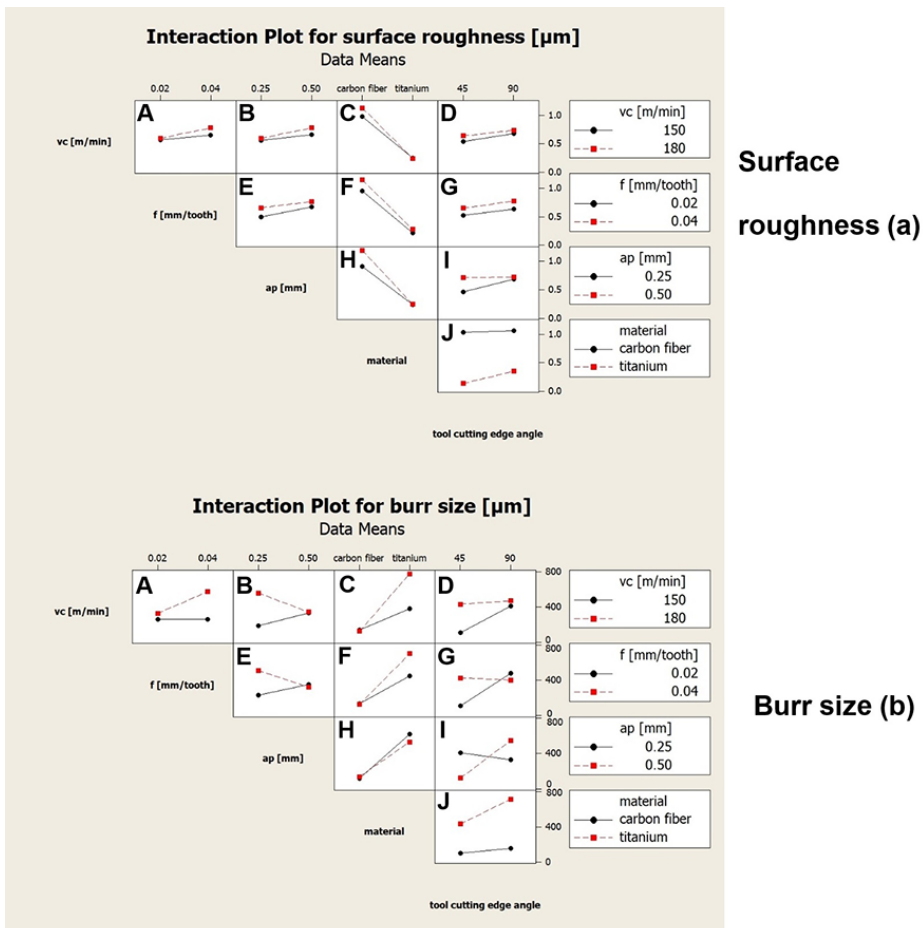
Figure 3. Interactions graphs between the factors over surface roughness and burrs